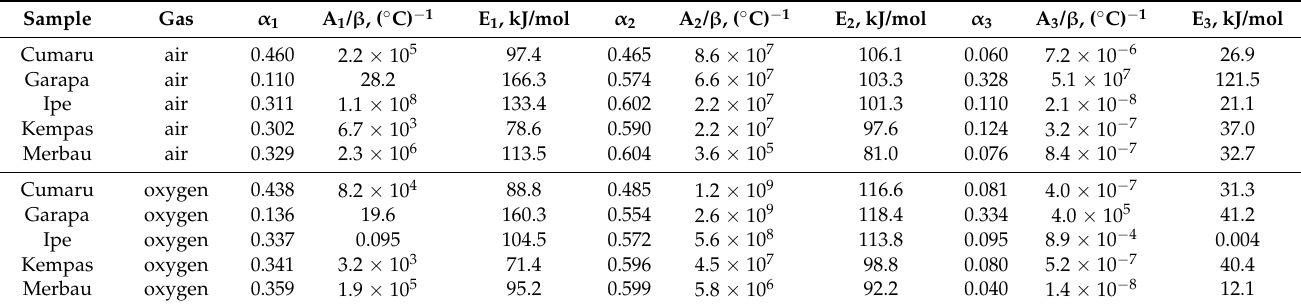
Table 1. Set of parameters from deconvolution of non-isothermal thermogravimetry runs (Equation (4)) for samples of tropical woods measured in air and oxygen (the rate of heating of 10 ◦ C/min.) ( α i is the fraction ascribed to the respective component of the whole degradation process, i = 1,2 and 3).